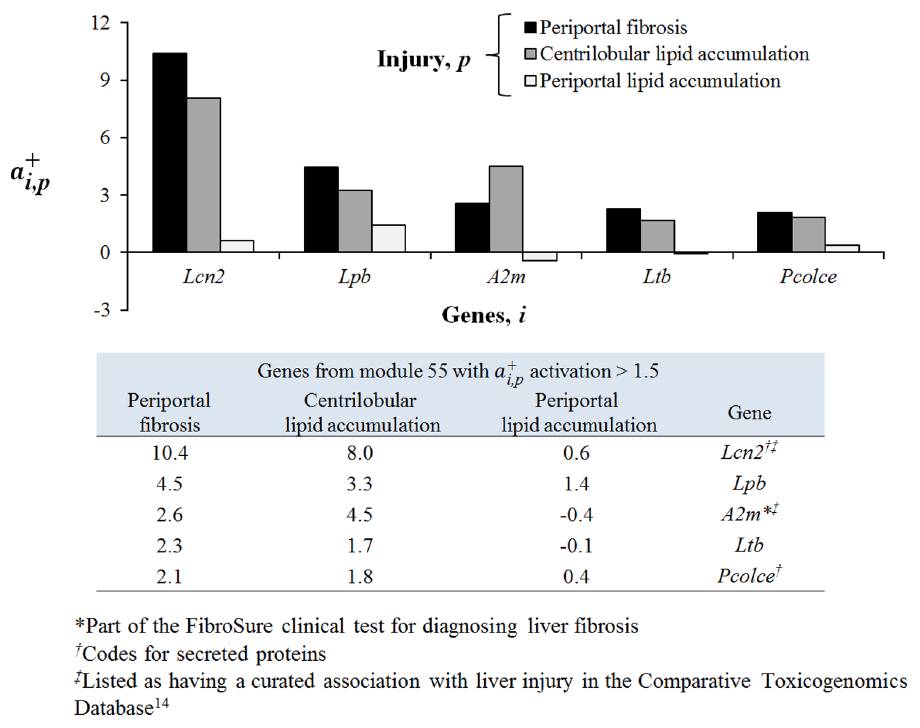
for fibrotic conditions. Lcn2 , i , p